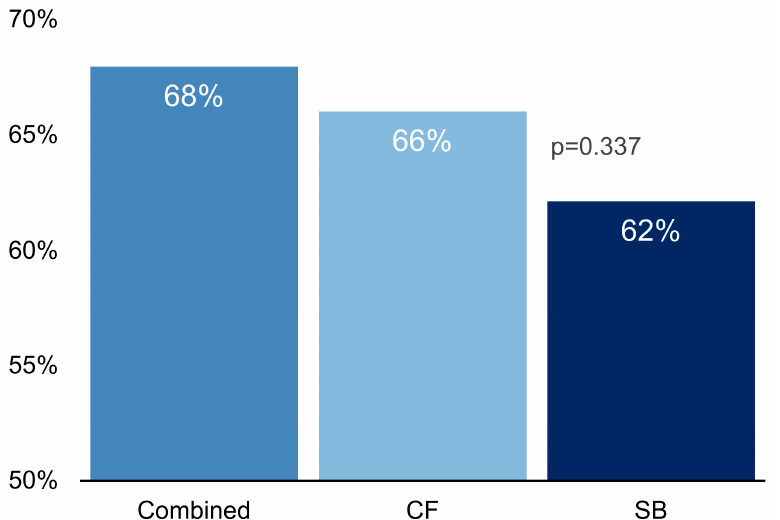
Figure 1. Diagnostic rate of transperineal ultrasound guided prostate biopsy types reveals that the combined method has the highest overall prostate cancer diagnostic rate, followed by CF and SB. No statistically signi fi cant di ff erence was found between CF and SB ( p = 0.337, chi-square test). CF = cognitive fusion biopsy, SB = systematic biopsy.